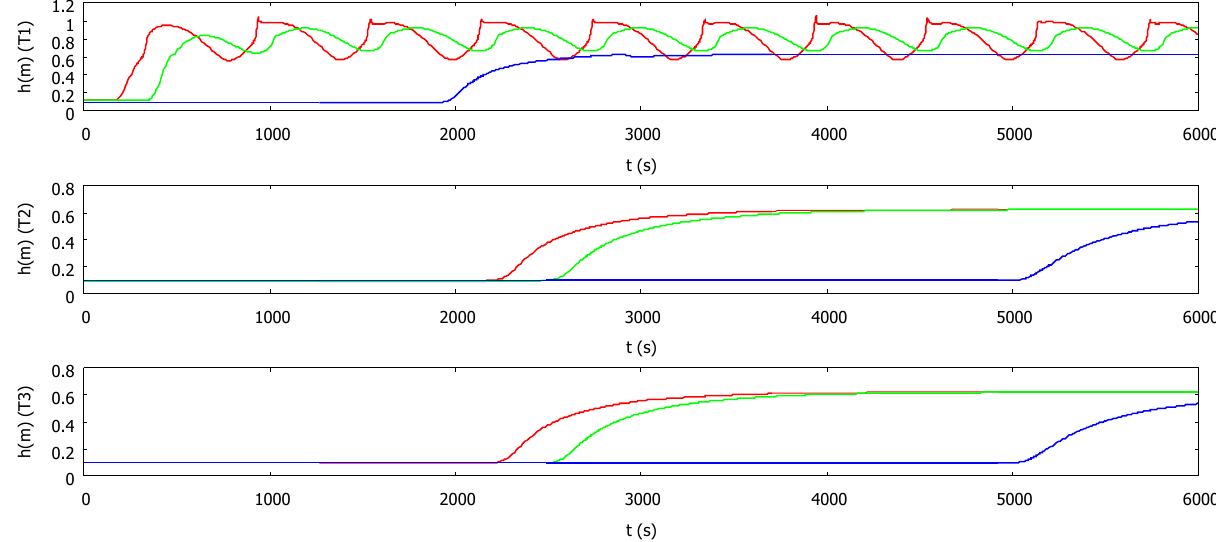
Figure 12. Pressurized transient in a pipe junction. Pressured head vs time x = 500 m (red), x = 1000 m (green) and x = 5000 m (blue).